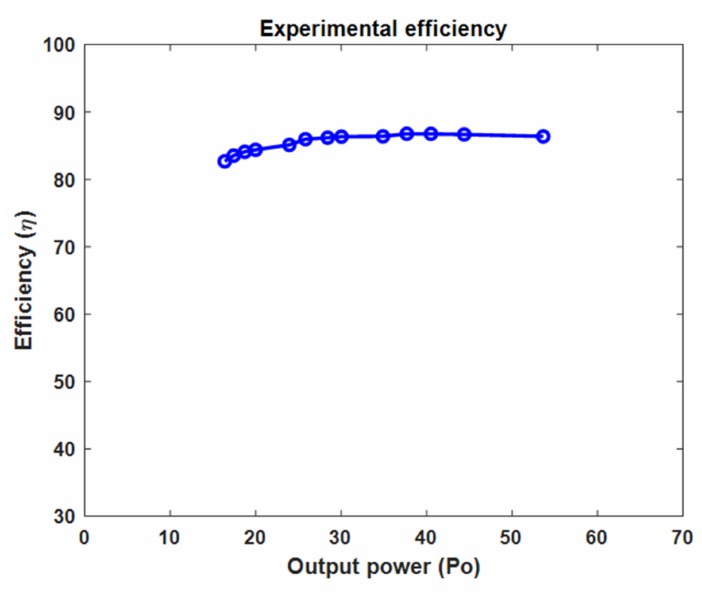
Figure 23. The experimental efficiency against the output power.